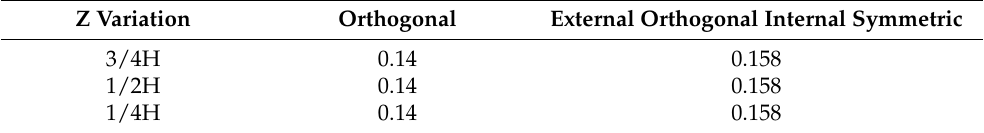
Table 6. Ellipticity results in simulation